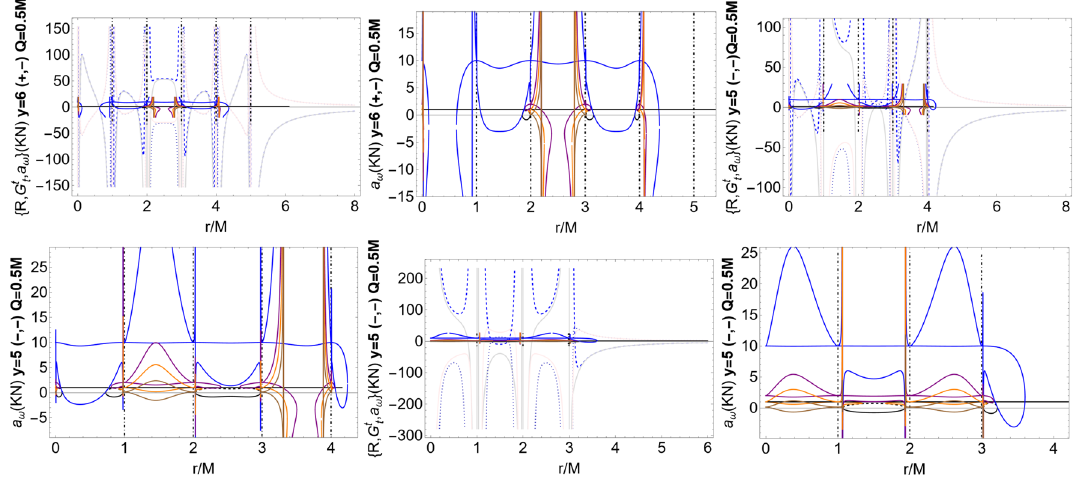
Fig. 24 Deformation of the Kerr–Newman reference metric in Boyer– Lindquist coordinates (metric signature ( − , + , + , + ) ) on the equato- rial plane ( θ = π/ 2) and M = 1. Metric bundle a ω , Ricci curva- ture scalar R and Einstein tensor component G t t are shown for charge Q = 0 . 5 and different deformation parameters { ( b , f ), y } , where { blue , purple , orange , bro w n } curves refer to frequencies { ω =